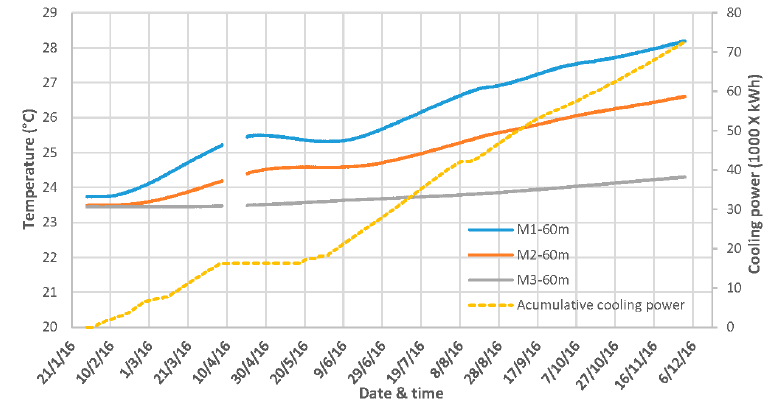
Figure 11. The ground temperature variation in the monitor boreholes of the DX system (M1, M2, M3) since the commission of the heat pump.